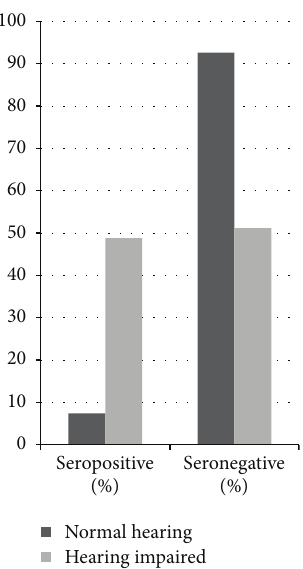
Figure 2: Rates of rubella IgG seropositivity among children with and without hearing impairment in Northwest Cameroon. Children with hearing impairment were significantly more likely to have positive serology ( 𝑃 < 0.0001 ), and children with normal hearing were significantly more likely to have negative serology ( 𝑃 < 0.0001